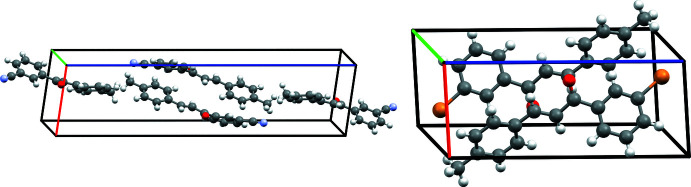
The unit cells of m′CNpCH3 (P21/c space group, left) and m′BrpCH3 (P
 space group, right), with the a, b, and c axes indicated in red, green, and blue, respectively.